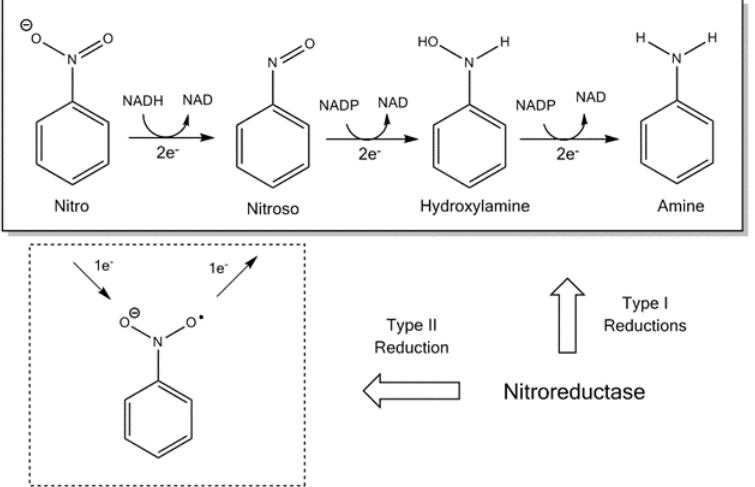
Figure 1. The reduction scheme of a nitro group and the respective electron transfers required [20]. NAD: nicotinamide adenine dinucleotide and NADPH: nicotinamide adenine dinucleotide phos- phate.